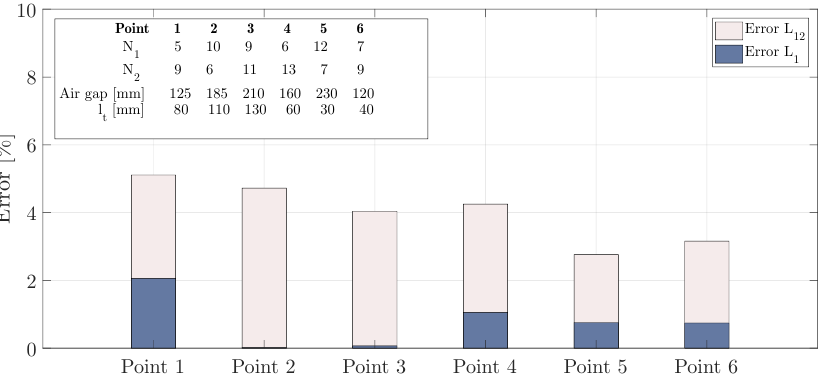
Figure 13. Estimation errors between the proposed fitting approach and FEA